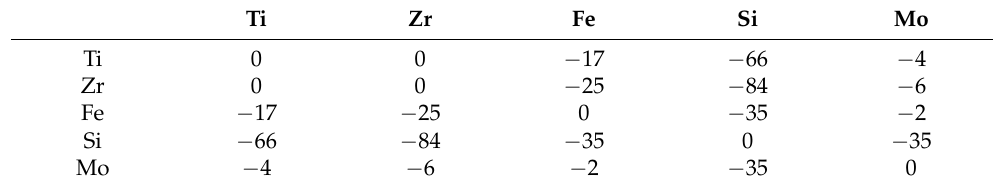
Table 2. The values of ∆ H mix /KJ/mol calculated by Miedema’s model for atomic pairs between elements. AB Ti Zr Fe Si Mo Ti 0 0 −